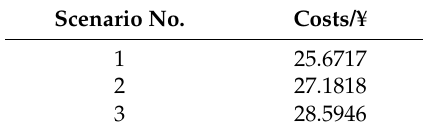
Table 4. Costs to customers in different